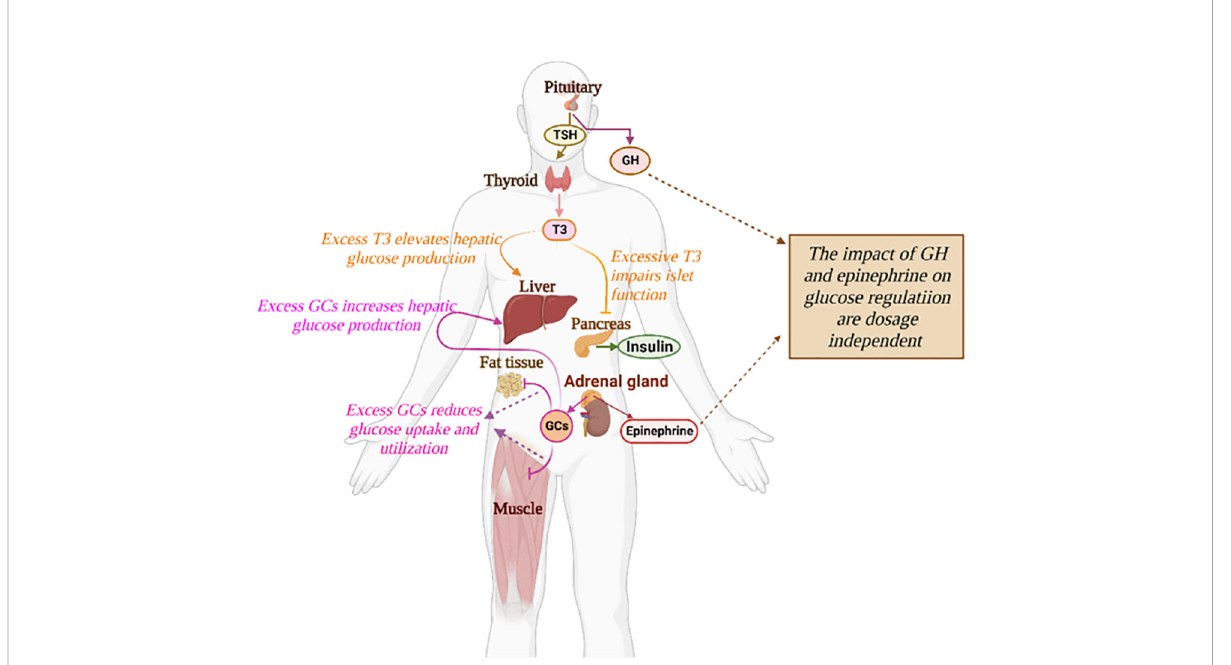
FIGURE 1 The impact of diverse hormones on the glucose regulatory system. The detailed in fl uences of a speci fi c hormone on glucose regulation are described in